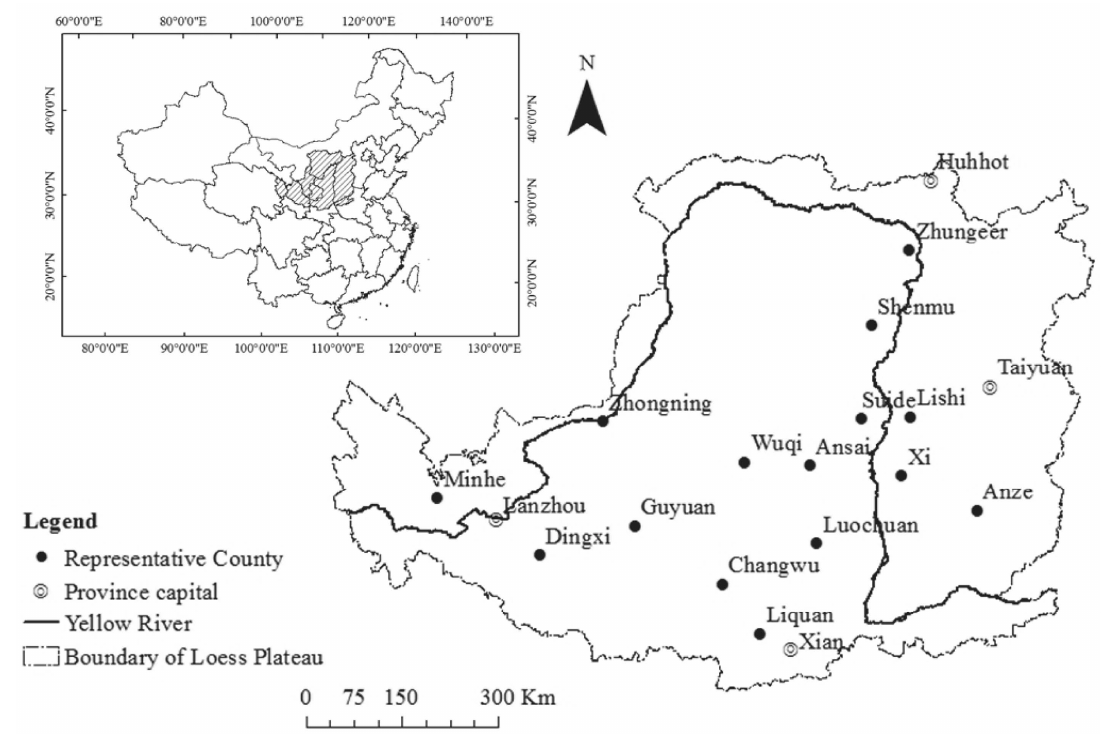
Figure 1. Location of the study area in China.